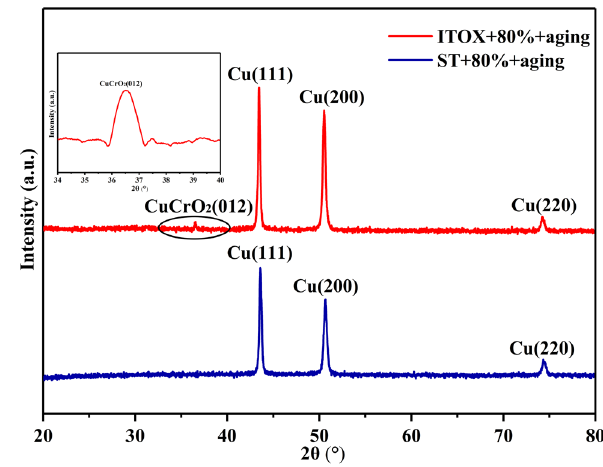
Figure 10: XRD patterns of the Cu – Cr – Ti alloy of ST + 80% + aging and ITOX + 80% +